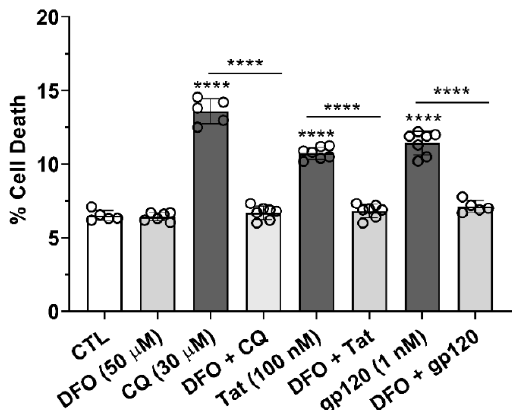
Figure 9. DFO blocked HIV ‐ 1 Tat ‐ and gp120 ‐ induced cell death. Propidium iodide was used to measure cell death on U87MG cells after 24 h of treatment with CQ (30 μ M), Tat (100 nM), and gp120 (1 nM). Cell death was significantly ( p < 0.0001) increased by Tat (100 nM), gp120 (1 nM), and CQ (30 μ M); 1 h pre ‐ treatment with DFO (50 μ M) blocked CQ ‐ , Tat ‐ , and gp120 ‐ induced cell death. A